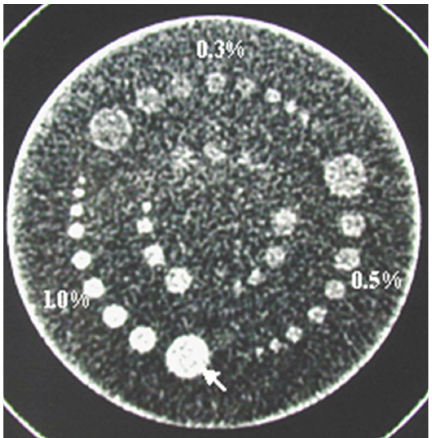
Figure 1: An axial CT image of the low-contrast module. It con- tains three groups of cylinders with various diameters from 2.0 to 15.0mm. The nominal contrast levels of these groups are 0.3%, 0.5%, and 1.0%. In our study, only the 15.0 mm diameter object with a contrast di ff erence of 1.0% (white arrow) was chosen to be